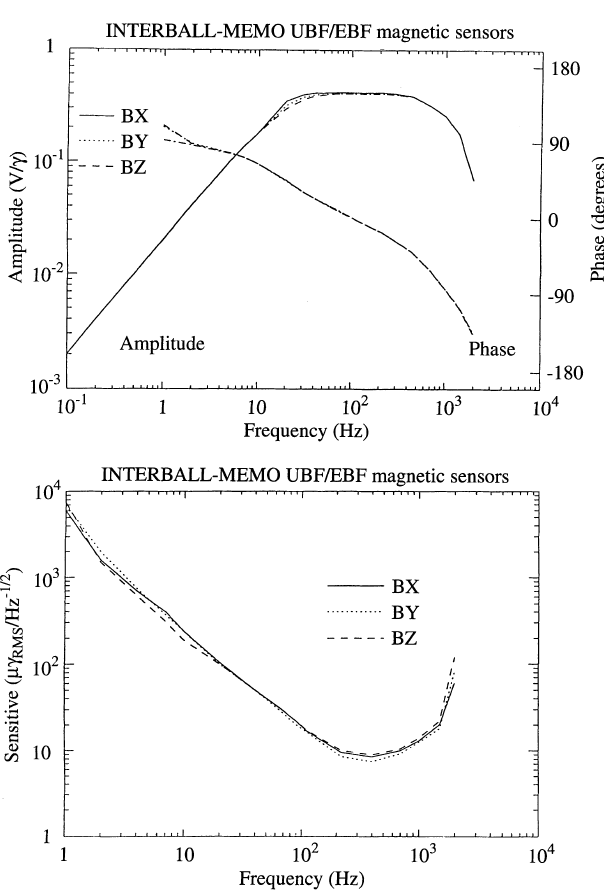
Fig. 2. Transfer functions and sensitivity curves of the UBF/EBF magnetic